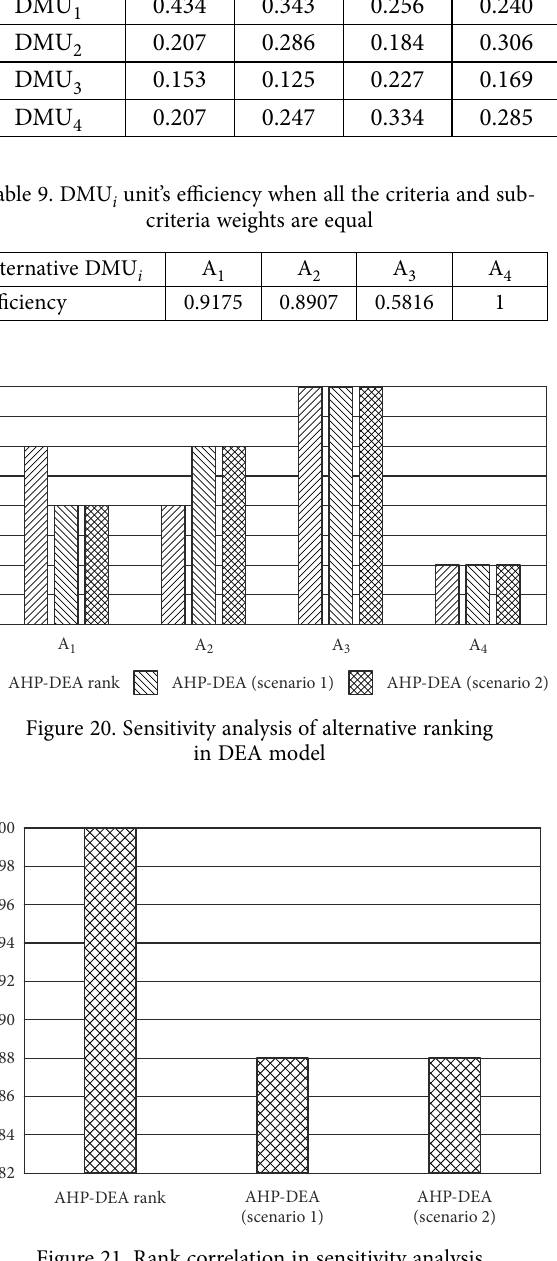
Figure 21. Rank correlation in sensitivity analysis in DEA